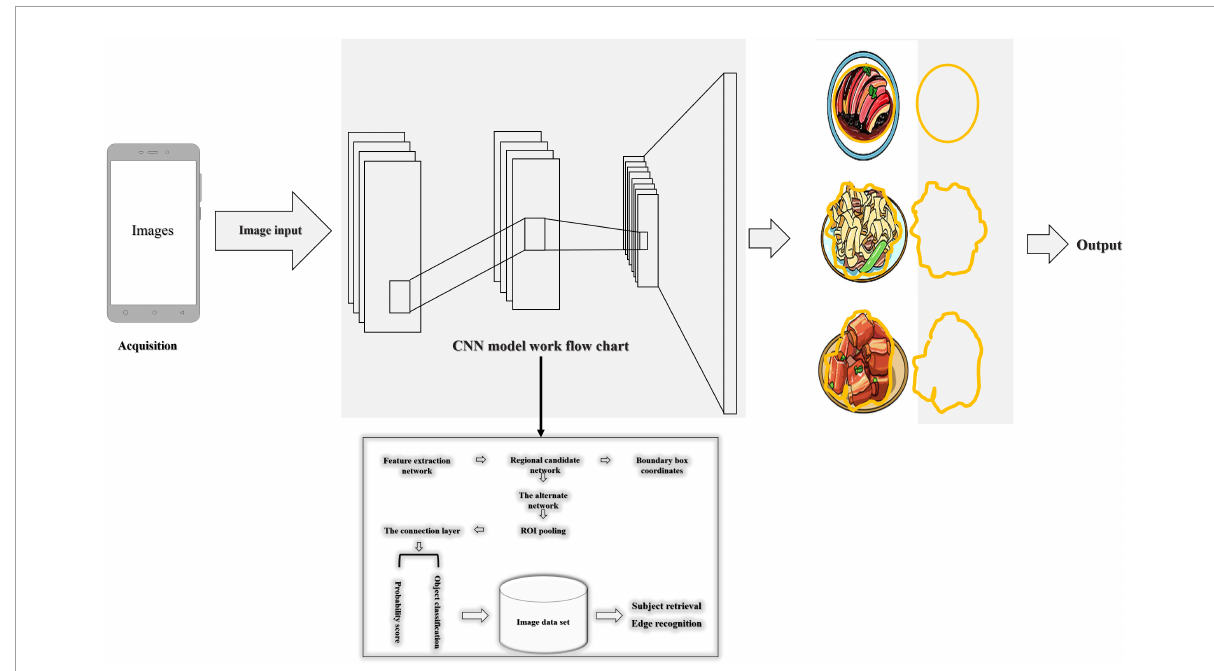
FIGURE3 Food area-weight calculation model based on the deep convolutional neural